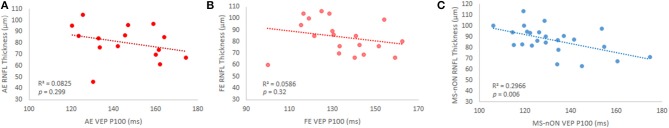
VEP P100 latency and pRNFL thickness correlations in subgroups. (A) MS-ON AE (p = 0.3); (B) MS-ON FE (p = 0.32); (C) MS-nON (p = 0.006).